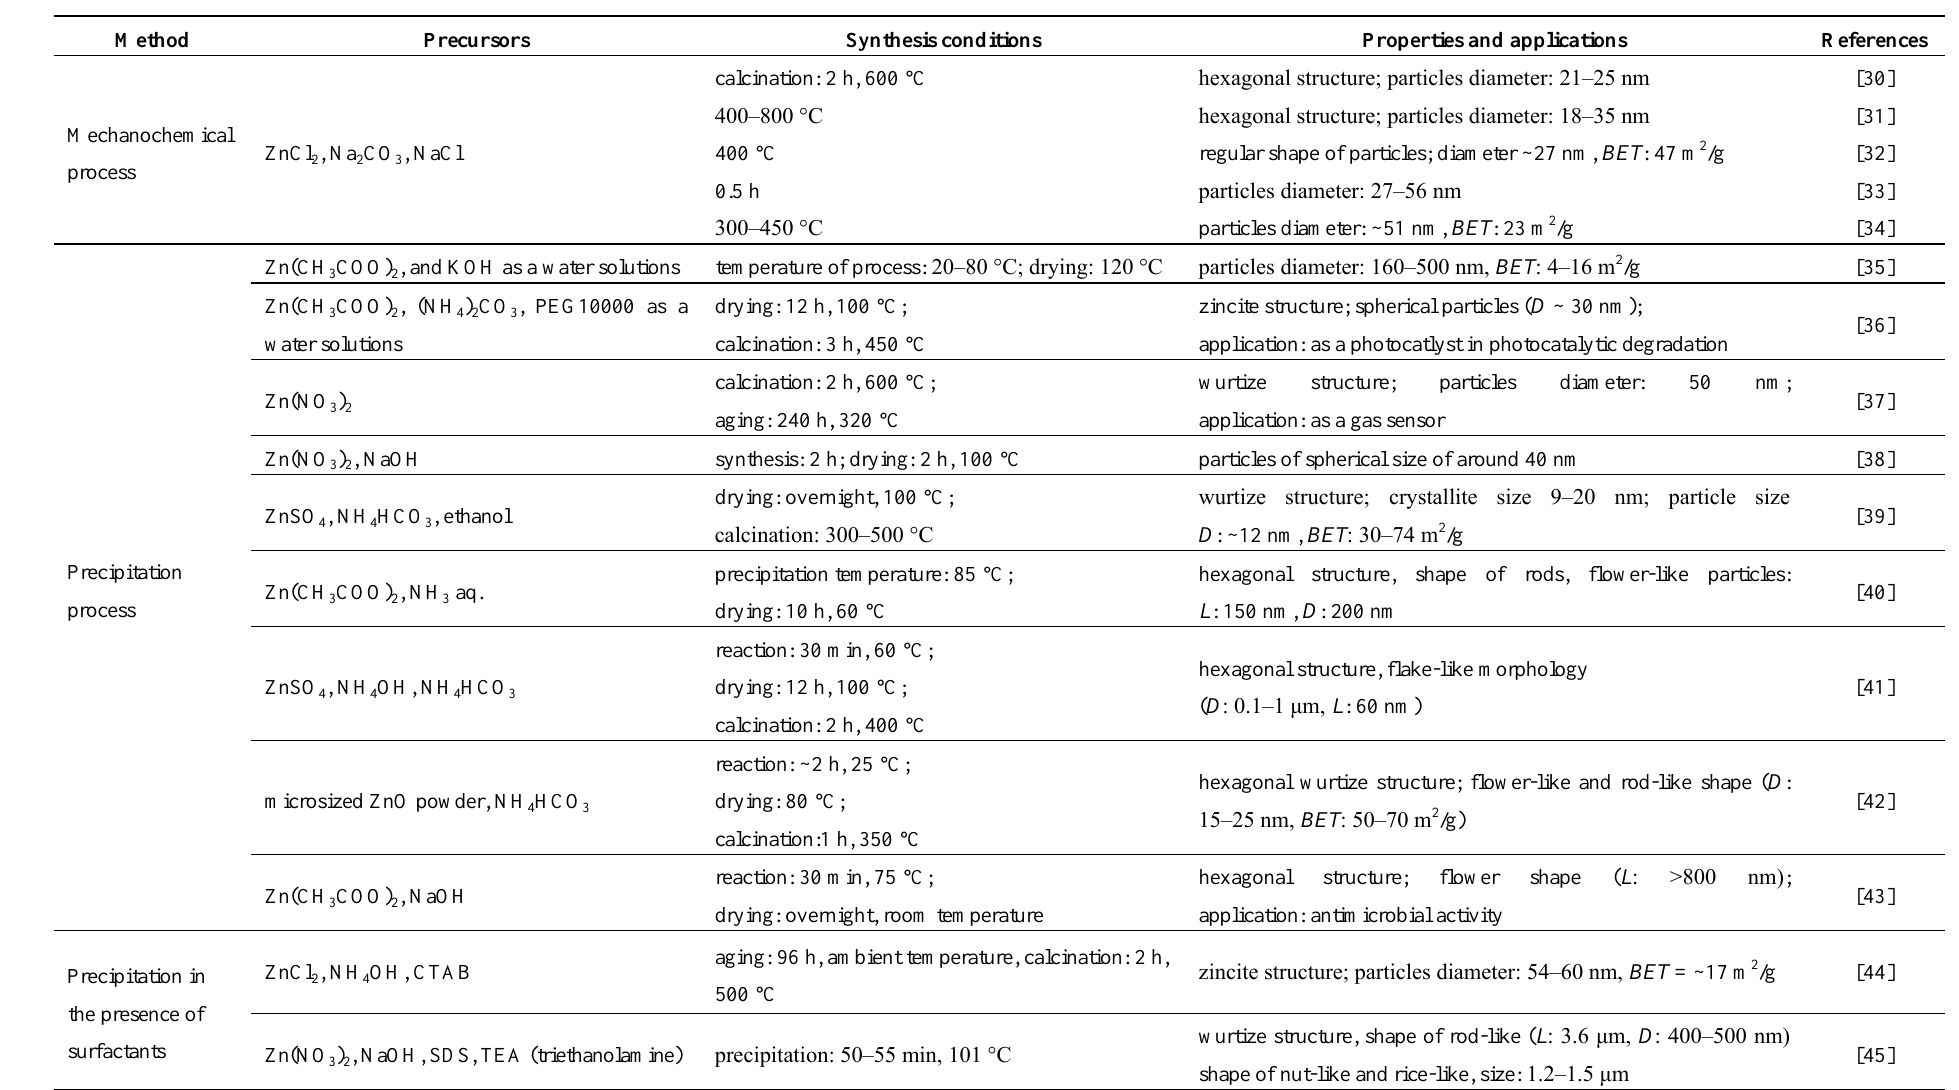
Table 1. Summary of methods of obtaining zinc